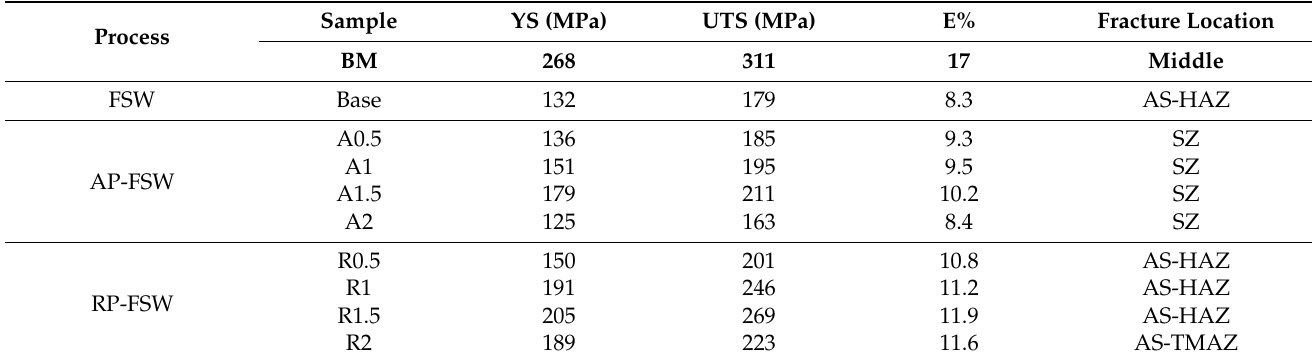
Table 4. Results of tensile